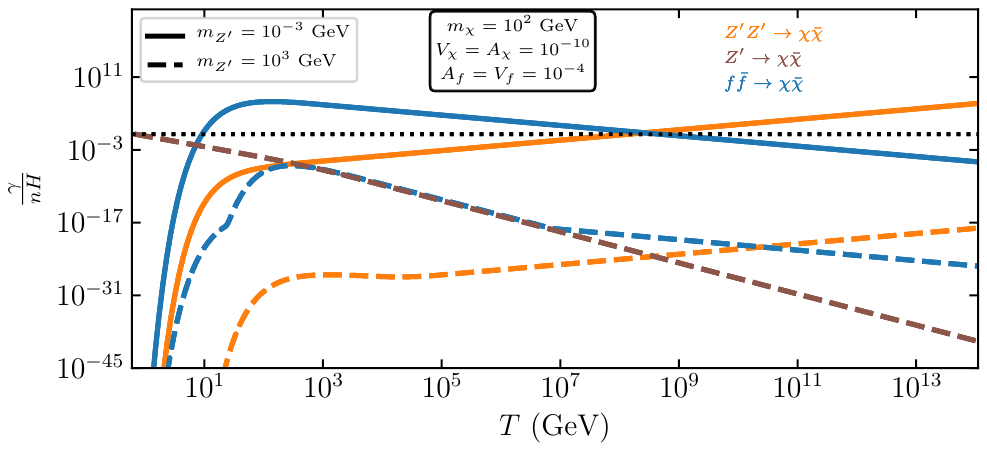
Figure 2. Ratios of the production rates ( γ/n ) to the Hubble rate ( H ) for the three DM production processes: Z 0 annihilations (in orange) and decays (in brown), and f annihilations (in blue). The dotted black line shows where γ/n = H . For this set of parameters, we can see that the freeze- in regime is achieved for m Z 0 = 10 3 GeV (dashed curves), whereas freeze-out occurs for m Z 0 = 10 − 3 GeV (solid